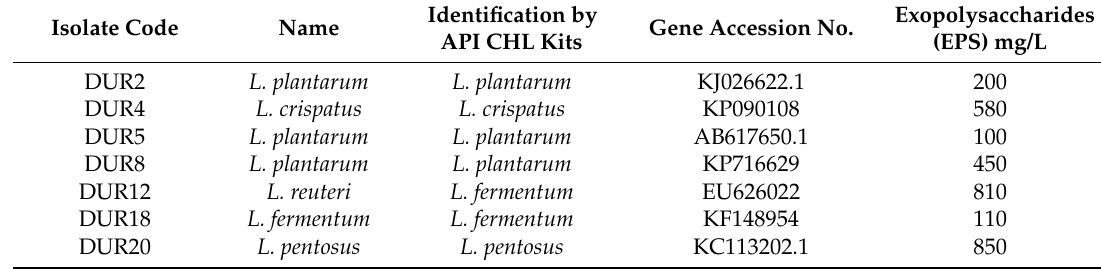
Table 1. Identification of the seven isolates using API 50 CHL kits and 16S rRNA gene.